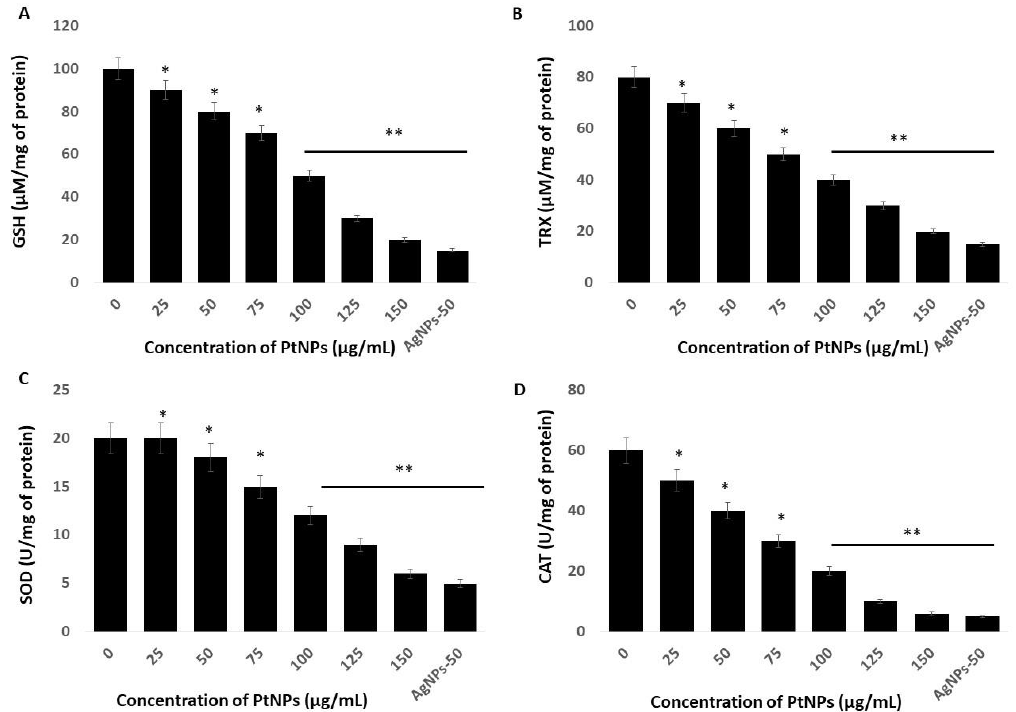
Figure 6. Effect of PtNPs on antioxidant markers. THP-1 cells were treated with different concentrations of PtNPs (25 – 150 µg/mL) for 24 h. After incubation, the cells were harvested and washed twice with ice-cold phosphate-buffered saline solution. The cells were collected and disrupted by ultrasonication for 5 min on ice. ( A ) Glutathione (GSH) concentration is expressed as µM per mg of protein. ( B ) Thioredoxin (TRX) concentration is expressed as µM per mg of protein. ( C ) Superoxide dismutase (SOD) is expressed as units per mg of protein. ( D ) Catalase (CAT) is expressed as units per mg of protein. Results are expressed as mean fold change ± standard deviation from three independent experiments. he treated groups showed statistically significant differences from the control group by the Student’s t -test (* p < 0.05; ** p < 0.01). * significant; ** highly significant.